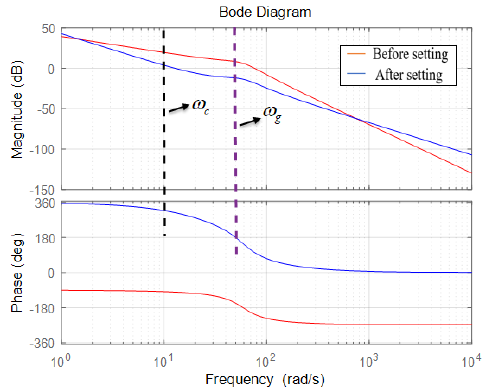
Figure 9. System bode diagram before and after Ziegler-Nichols frequency setting.